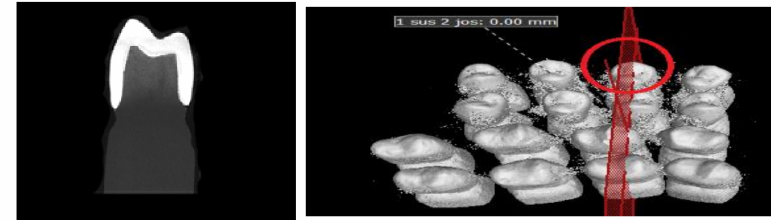
Figure 8. Images from the micro-CT program—ZLSM samples.